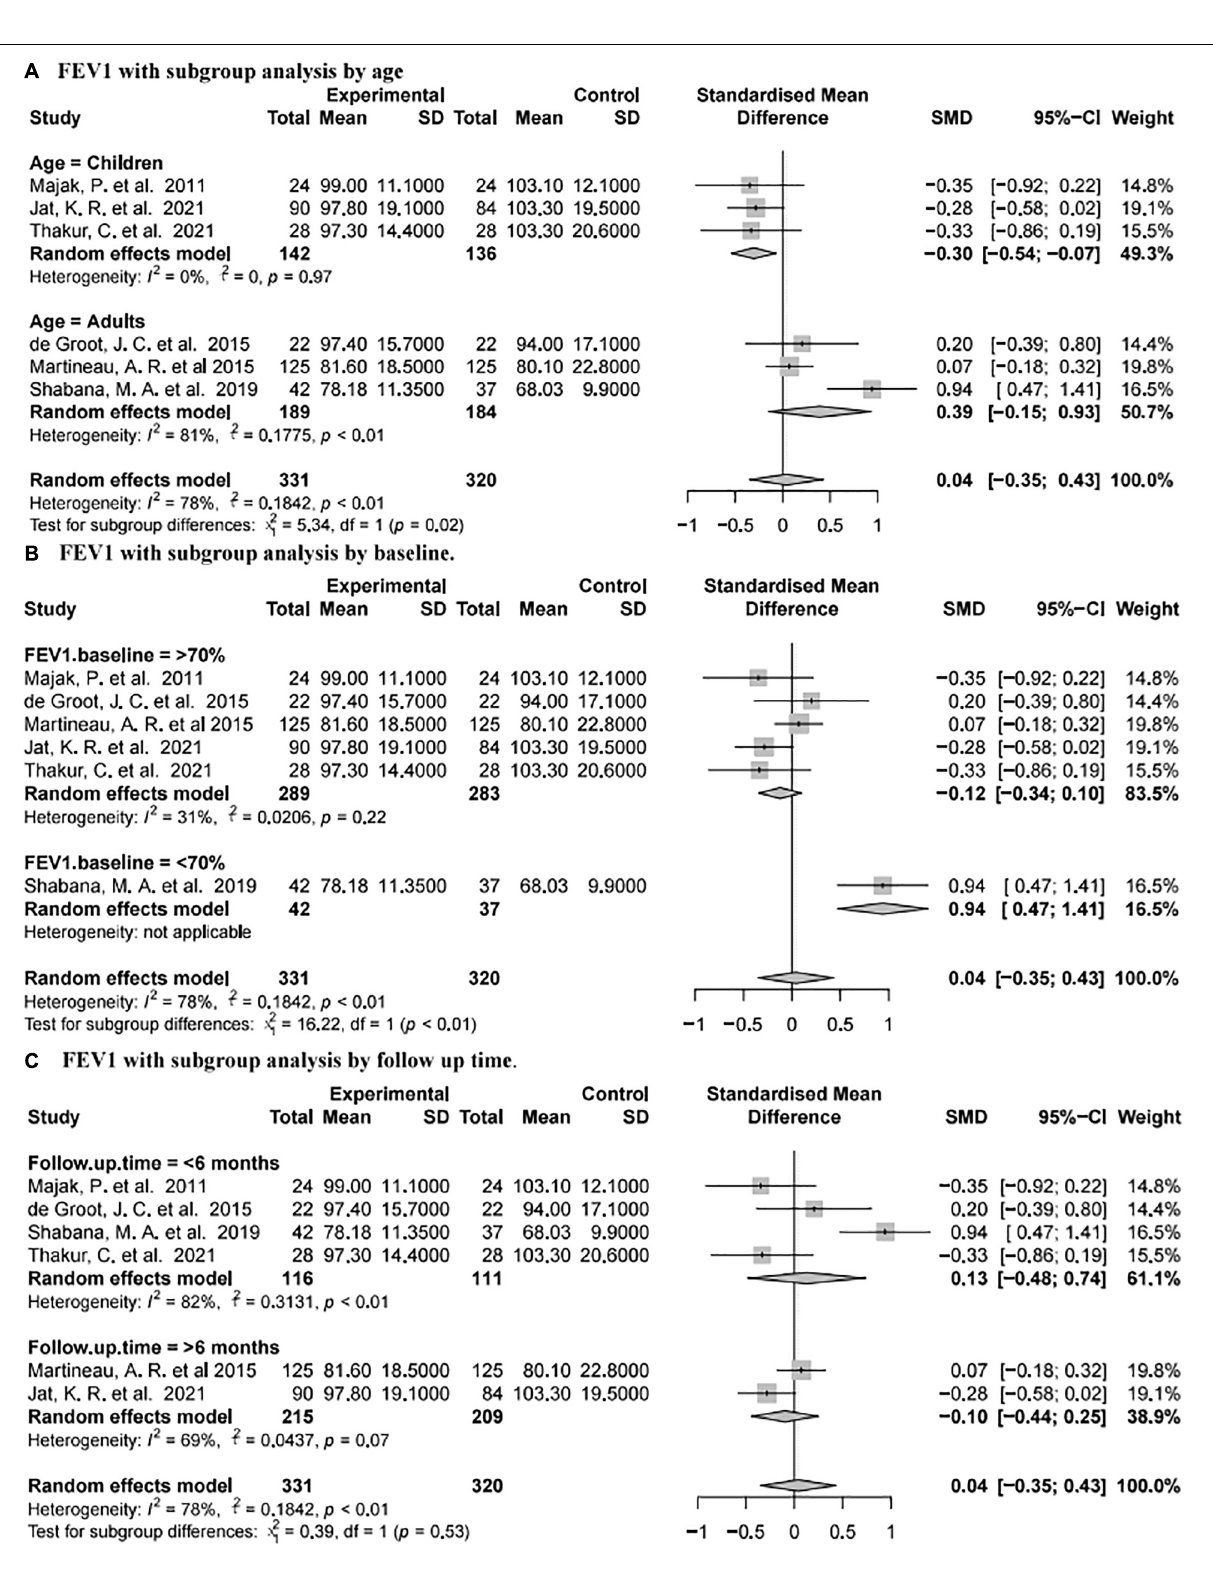
FIGURE 5 | Forest plot random effect model for vitamin D supplementation for FEV1 with subgroup by various factors.